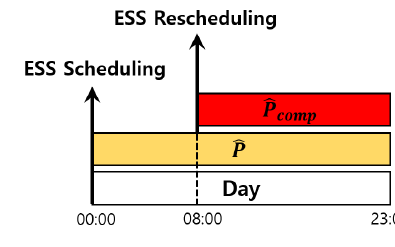
Figure 6. Two-stage ESS scheduling.